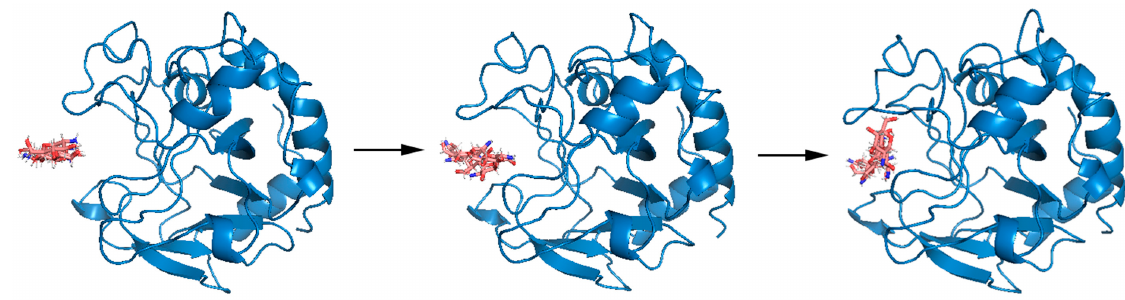
Figure A6. A typical binding process of chitosanase and DP6-chitosan at 300 K.